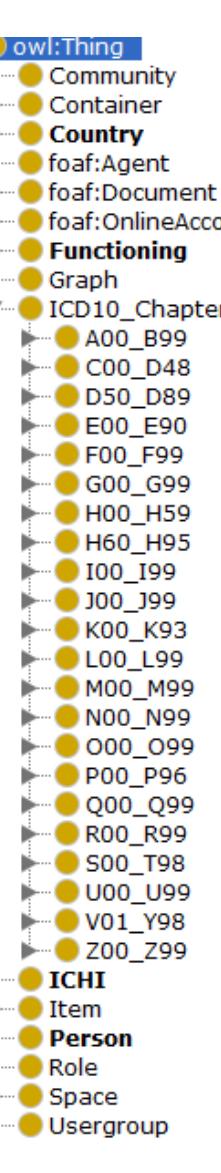
Figure 1. Class diagram of the proposed